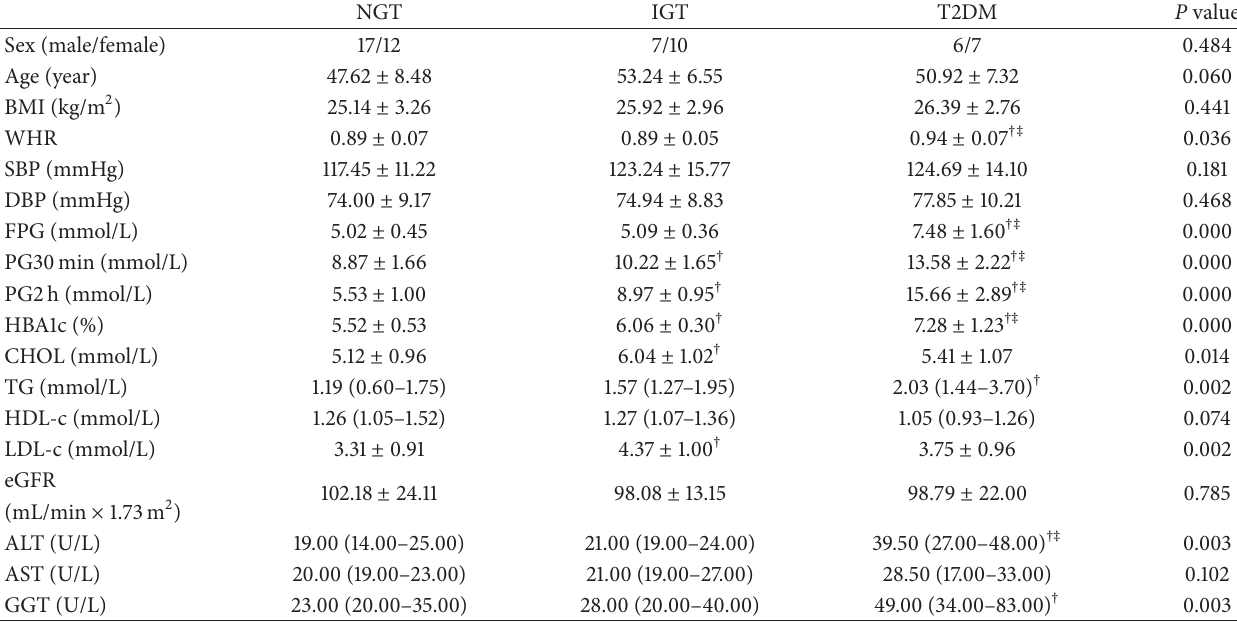
Table 1: Clinical and biochemical characteristics.